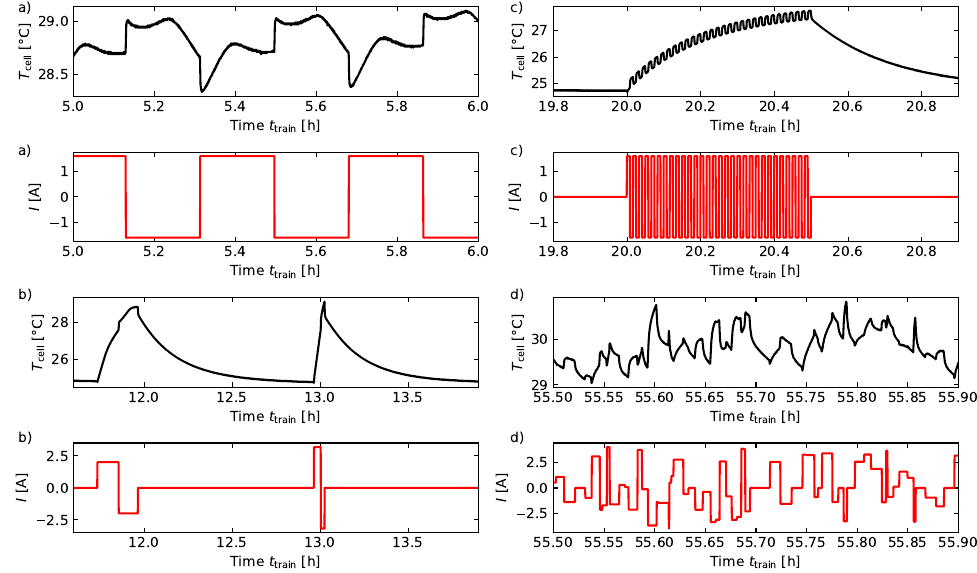
Figure 4. Enlarged view of the areas marked in Figure 3. Presented are temperature response T cell ( t train ) and current profile I ( t train ) of each of the marked ares ( a – d ). Figure 5 shows the data used to validate the models. Every scenario described for the training data is implemented here as well. However, it was ensured that the current values I differ from the training data set. Analogous to Figure 4, there is an enlarged view of all scenarios in Figure 6 showing T cell as well as the current I .